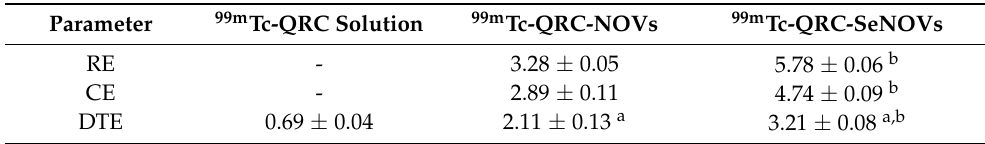
Figure 8. QRC tumor accumulation at various time intervals following i.v. administrations of 99m Tc-QRC solution, 99m Tc-QRC-NOVs, and 99m Tc-QRC-SeNOVs in Ehrlich tumor-bearing adult male Swiss albino mice, mean ± SD, n = 3. Table 6. Tumor specific targeting parameters after i.v. administrations of 99m Tc-QRC solution, 99m Tc-QRC-NOVs, and 99m Tc-QRC-SeNOVs to Ehrlich tumor-bearing